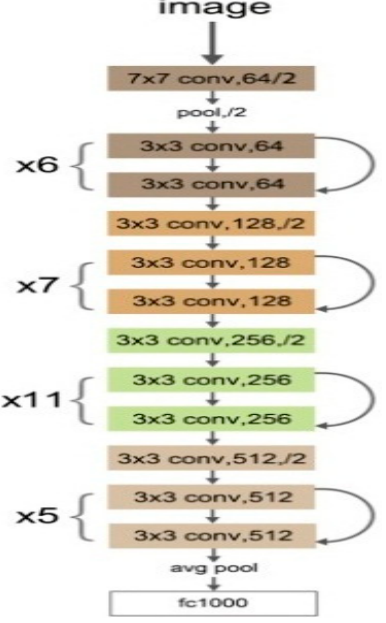
Figure 5. The main architecture of deep ResNet-34 network.